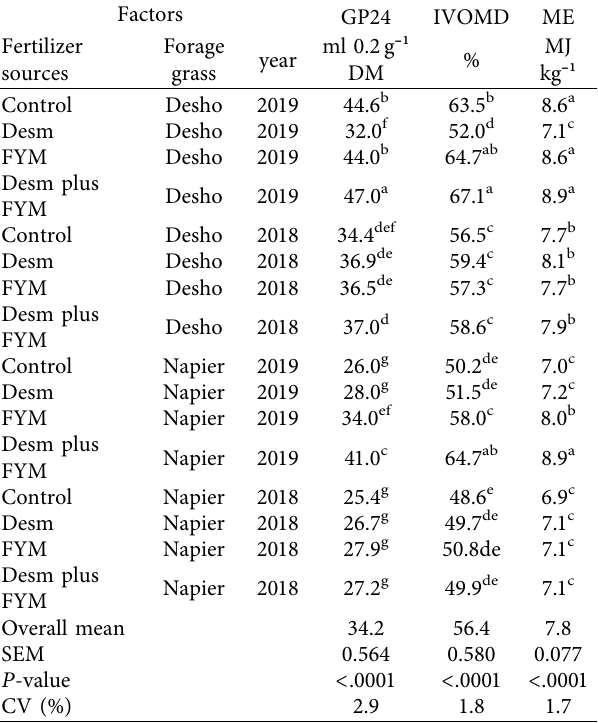
Table 3: Results of Tukey’s tests exploring the interaction effects of forage grasses, fertilizer treatments, and year on GP24, IVOMD, and ME contents at the Aba Gerima watershed.